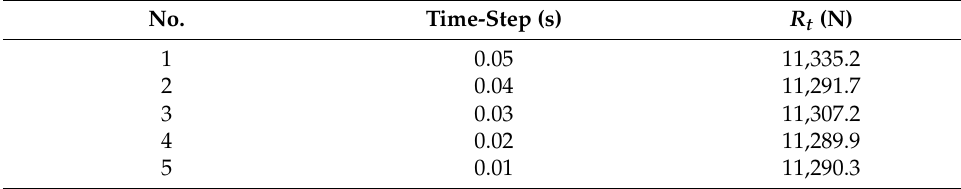
Table 3. Time step convergence study (α = 90 °).